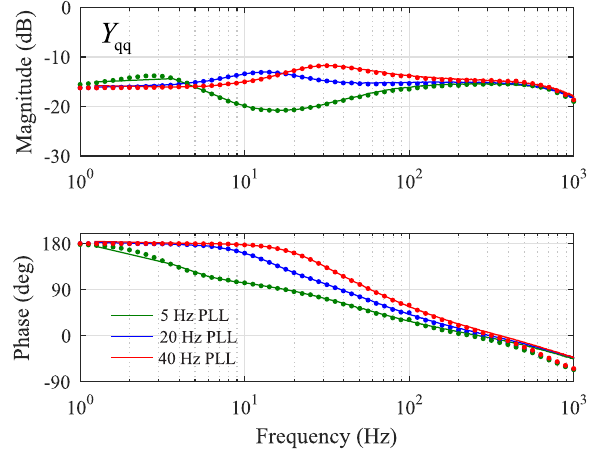
Figure 13. Admittance q-component with different phase-locked-loop crossover frequencies.